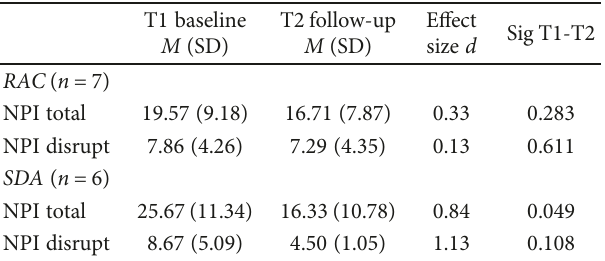
∗ denotes the total score (composite measure) derived from subscales assessing perceived self and organisational e ffi cacy in managing BPSDs. Table 3: Means, standard deviations, and e ff ect sizes on the NPI- NH.